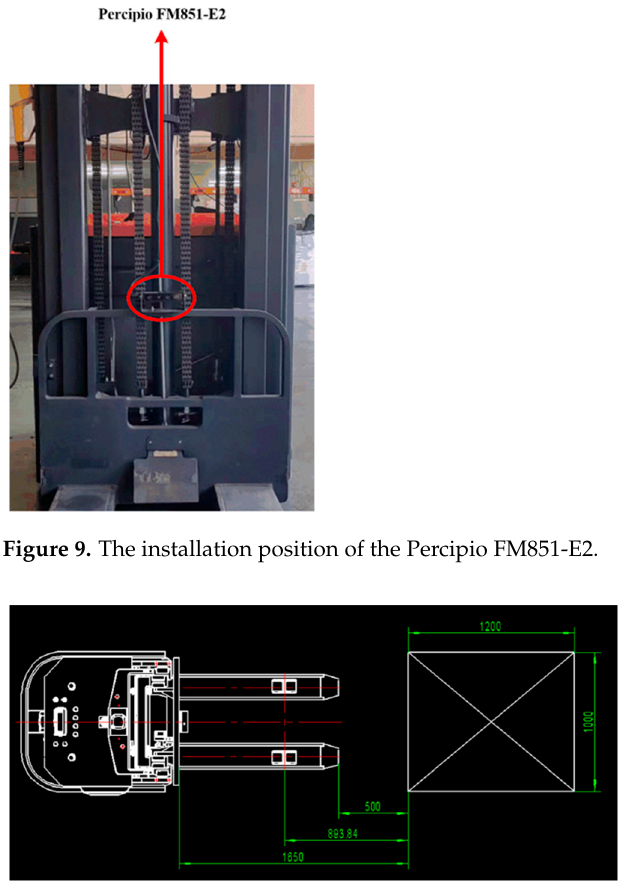
Figure 8. Structure of Percipio FM851-E2.